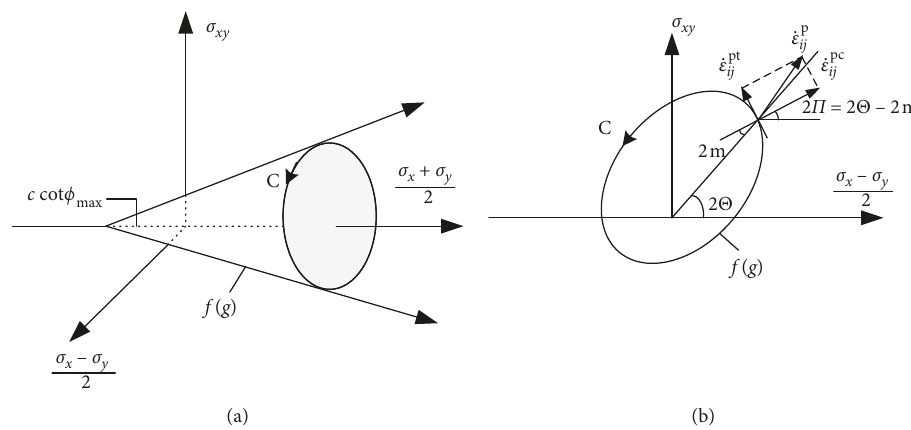
Figure 2: Display of the non-coaxial plastic flow rule [24, 27].